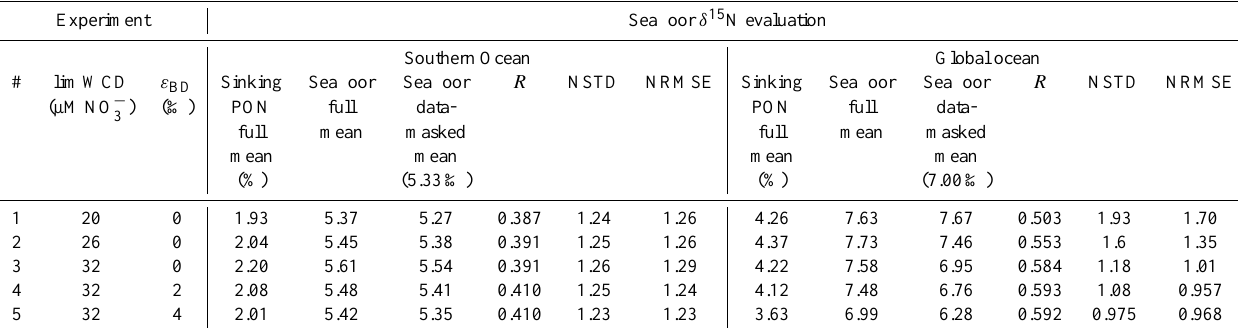
Table 3. Measures of seafloor δ 15 N model performance ∗ . Experiment